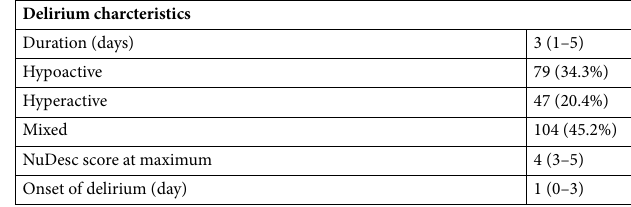
Table 1. Delirium characteristics. p value reported in bold if difference is significant (p < 0.05). Data are given as median and interquartile range (25th-75th) or number of patients (percent of all